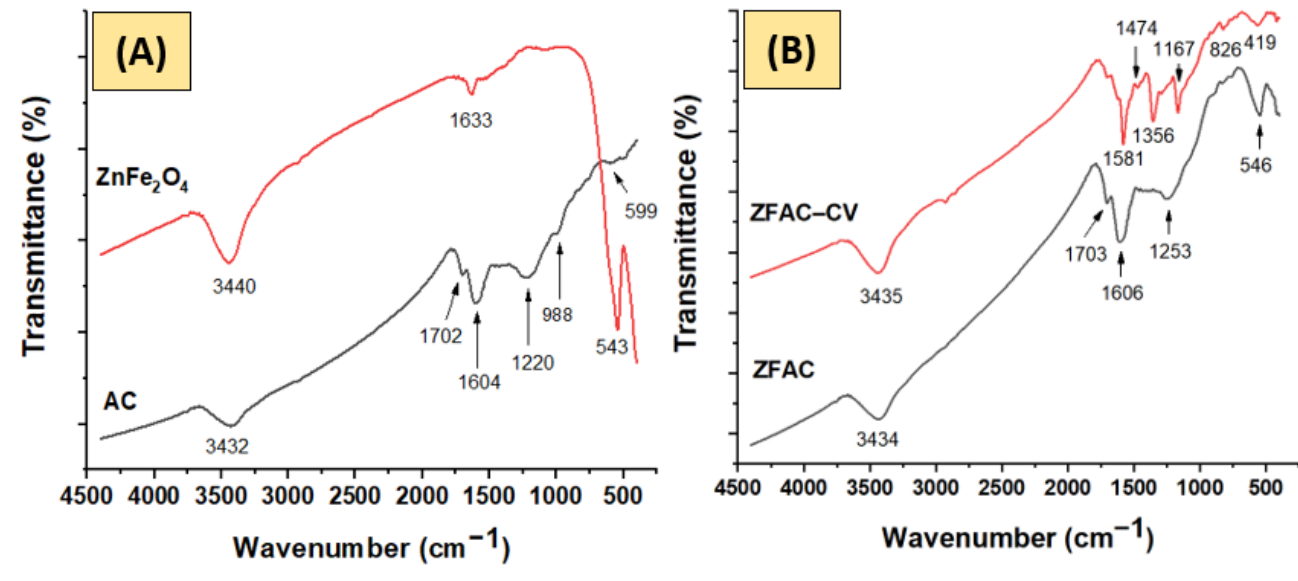
Figure 2. FTIR spectra of: ( A ) activated carbon (AC) and metal oxide (ZnFe 2 O 4 ); ( B ) adsorbent (ZFAC) and crystal violet (CV)-loaded adsorbent (ZFAC–CV). (ZFAC) and crystal violet (CV)-loaded adsorbent